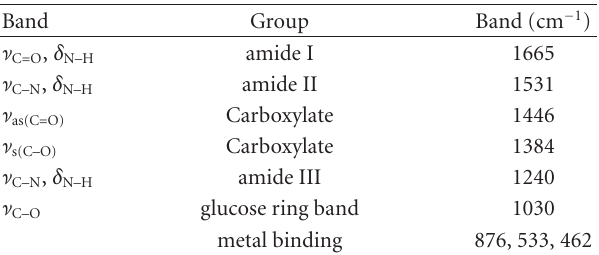
Table 2: Metal sensitive IR vibrational frequencies of water washed C hlorella vulgaris.